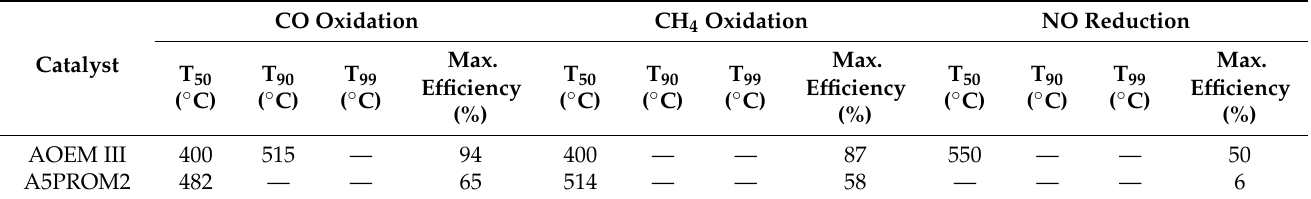
Table 7. Comparison of aged tested catalysts OEM III and 5PROM2 under rich-burn conditions ( λ = 0.99).